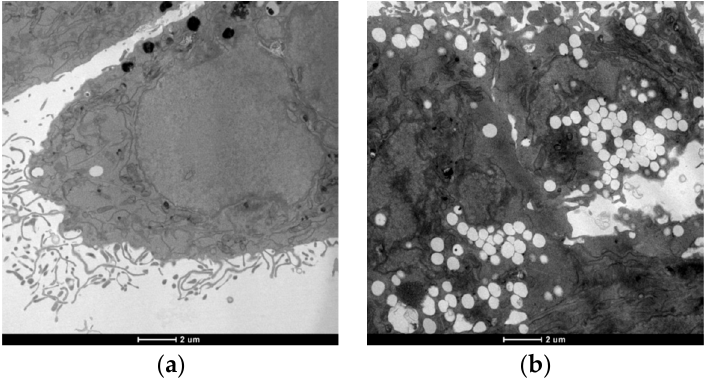
Figure 7. TEM analysis. LoVo cells after 24 h of treatment with ( a ) control; ( b ) IC 50 of 1 .